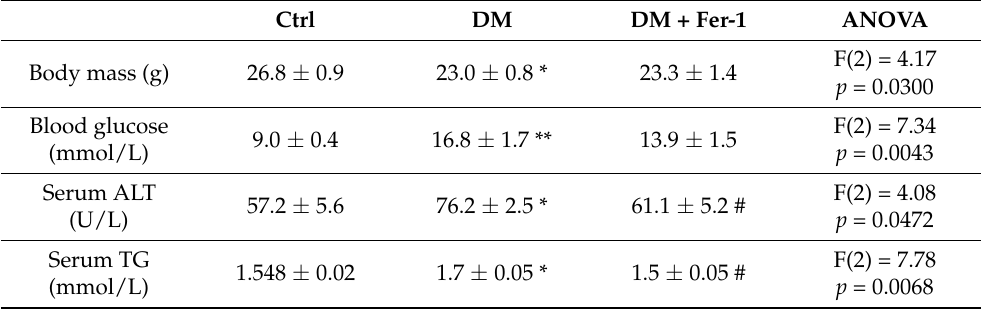
Table 1. Physical and biochemical characteristics of the experimental groups.